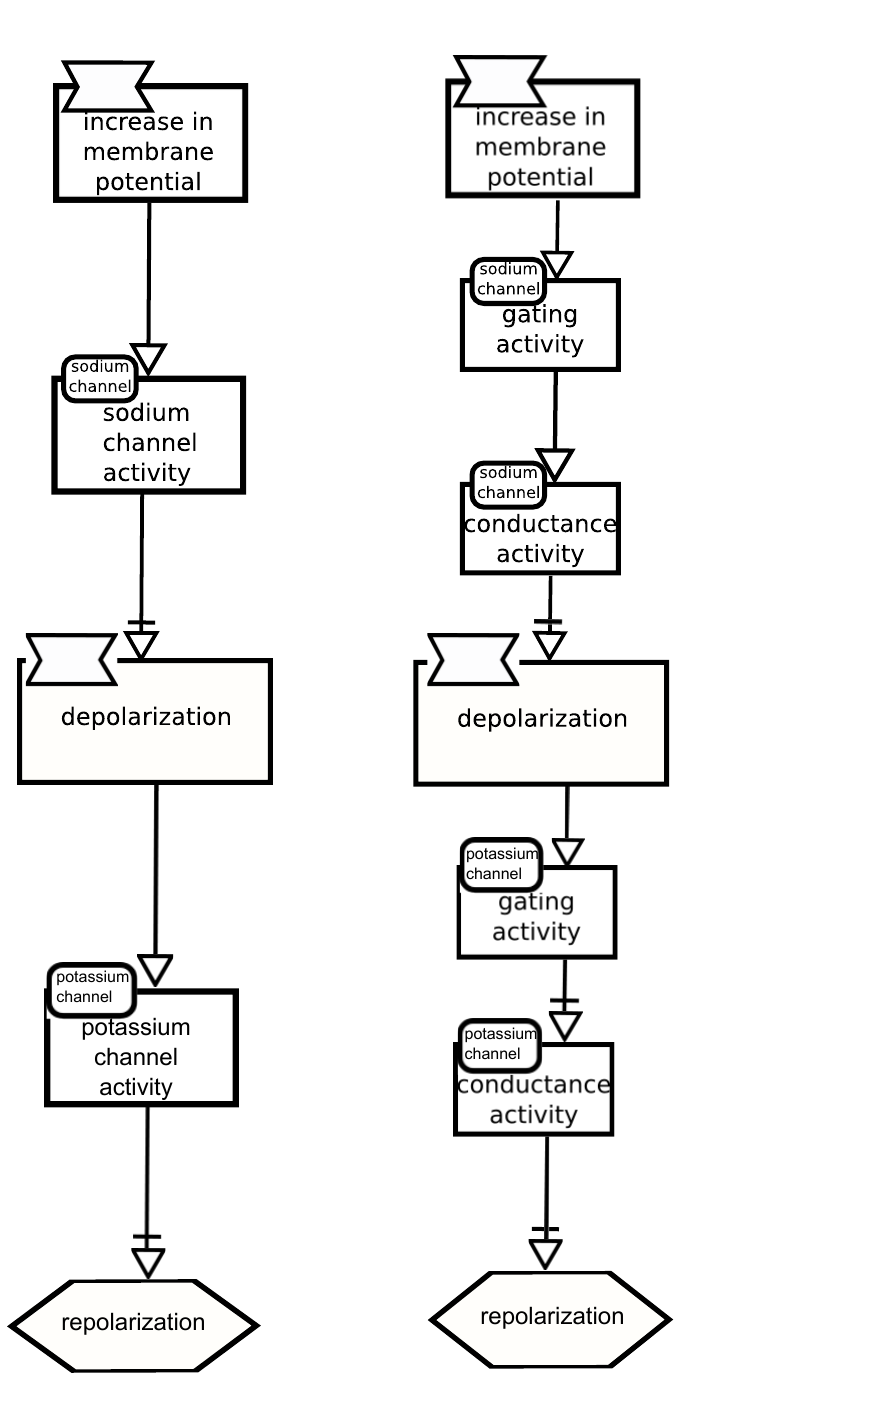
Figure A.4: Two views of the role voltage-gated sodium channel plays in action potential generation illustrated by SBGN Activity Flow Level